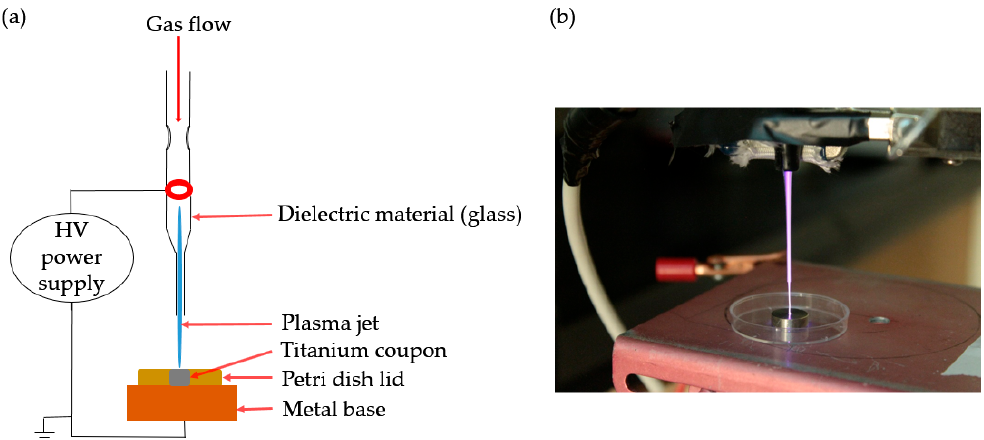
Figure 5. Schematic diagram and photograph of the jet plasma setup. ( a ) demonstrates the schematic diagram of the jet plasma and ( b ) shows the actual experimental setup of jet plasma [69,96].